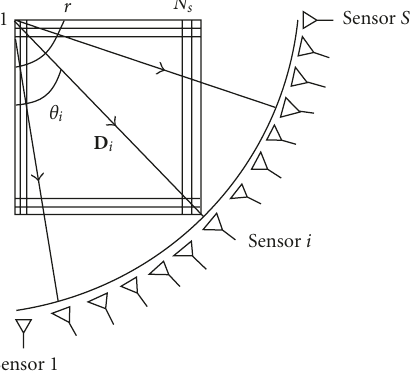
Figure 2: A subimage is extracted from the processed image: its top left corner is the center of the expected circle of radius r . The subimage is associated with a circular array composed of S sensors.